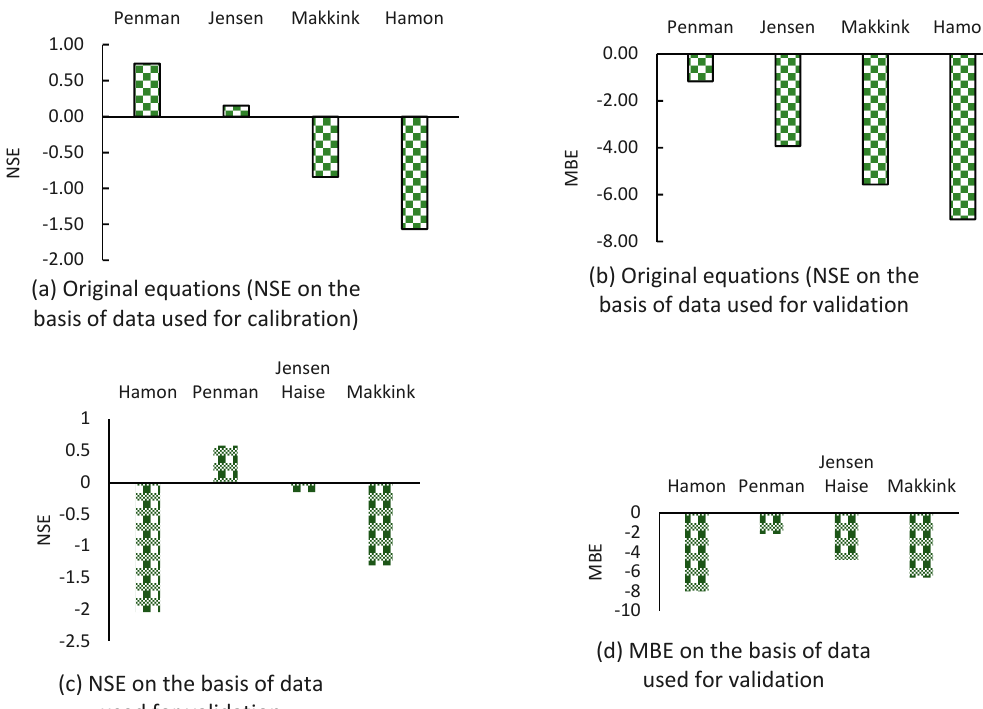
Figure 6. Error values for simulated evaporation obtained from various original equations: ( a ) Nash and Sutcliffe Efficiency (NSE) for data used in calibration, ( b ) Mean Biased Error (MBE) for data used in calibration, ( c ) NSE for data used in validation, and ( d ) MBE for data used in validation.